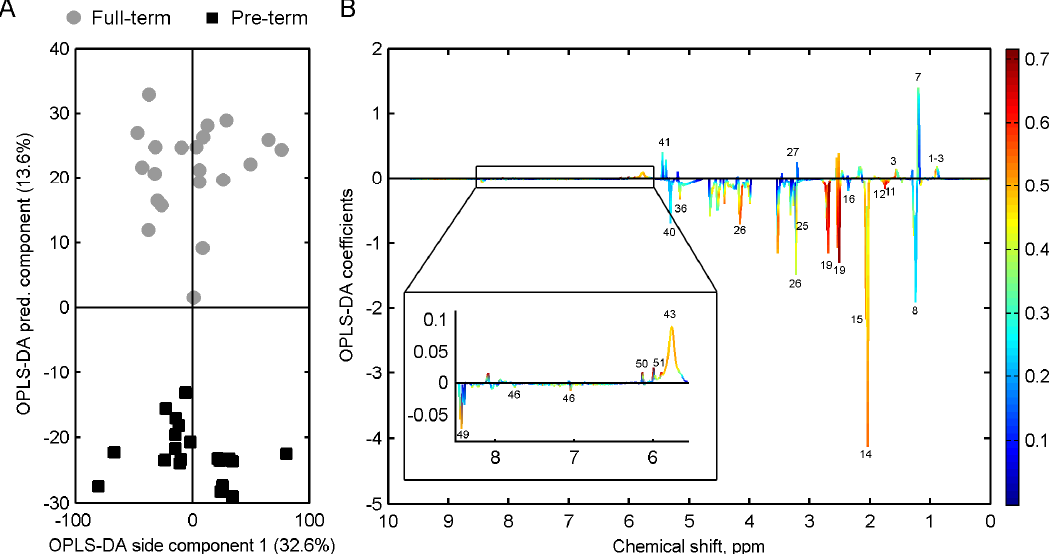
Figure 6. ( A ) Orthogonal partial least squares discriminant analysis of pre-term ( n = 20, days postpartum range 3–14 weeks) and full-term ( n = 21, days postpartum range 3–26 weeks) milk. Full-term colostrum, transitional, and pre-term milk <2 weeks postpartum have been excluded. Cross-validation, Q2: 0.70; ( B ) corresponding OPLS-DA coefficients plot. Each variable has been coloured according to the OPLS-DA loadings (correlation between NMR variables and pre-term/ full-term classes); for peak assignments refer to Table 3.